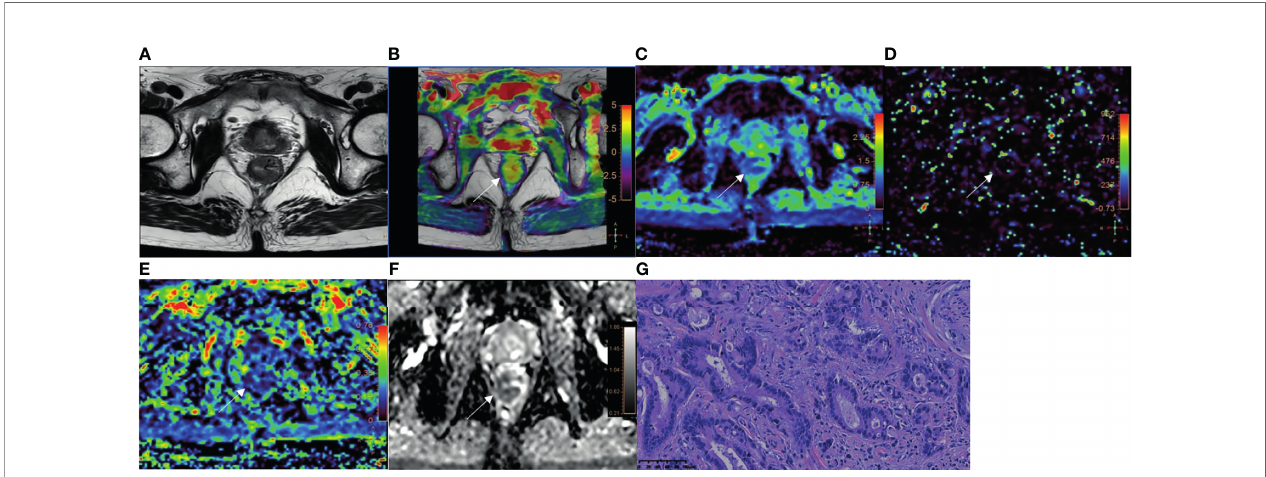
FIGURE 4 | A 78-year-old male with AC of grade 3. (A) Oblique axial T 2 -weighted image showed a mass with slightly high intensity in the rectum. (B) APT-T2 merged image showed the mass with a mean APT SI of 2.8%. (C – E) D, D* and f maps showed the mass with values of 0.79×10 -3 mm 2 /s, 9.40×10 -3 mm 2 /s and 0.17, respectively. (F) The mass showed low intensity (0.93×10 -3 mm 2 /s) on the ADC map. (G) HE staining revealed poorly differentiated adenocarcinoma. (×200).